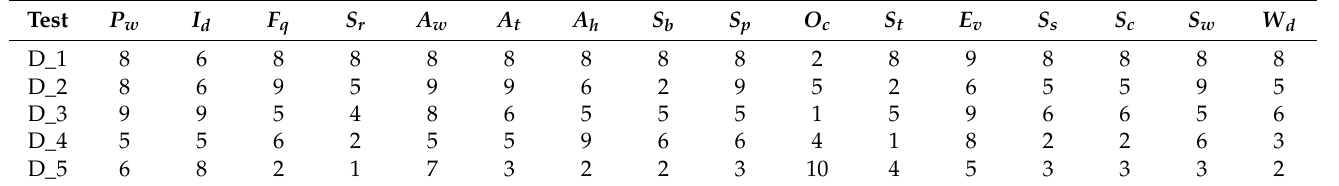
Table 7. Orthogonal test parametric arrangement for sprinkler drip irrigation in saline–alkali soil.